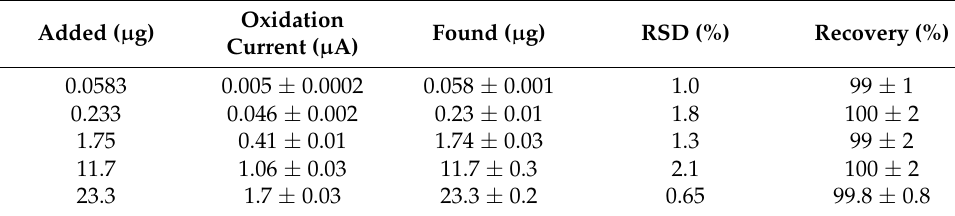
Table 3. Indigo carmine determination in model solutions ( n = 5; p =